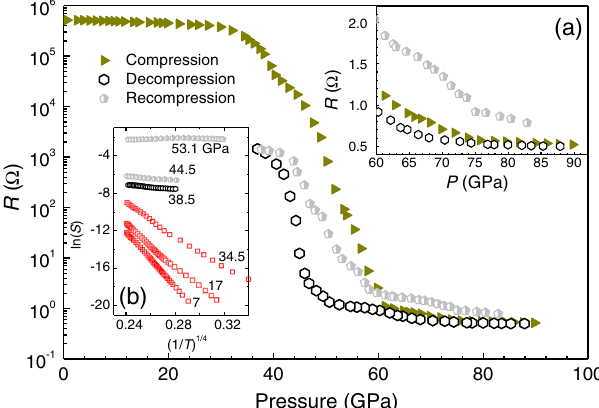
FIG. 10. Pressure dependence of electrical resistance at 298 K. The solid triangles, open hexagons, and half-filled pentagons show data recorded upon compression, decompression, and successive recompression, respectively. Inset (a): our results for pressures of 60 – 90 GPa; inset (b): temperature dependence of electrical conductance S of Fe 2 O 3 , with measurements on the DPv phase performed during decompression to 37 GPa, followed by recompression. Measurements on the hematite phase were collected during a separate decompression cycle to ambient pressure (symbols “ square ” ) [55]. The change in sign of the slope dln ð S Þ =dT documented at approximately 53 GPa is the signature of metallic